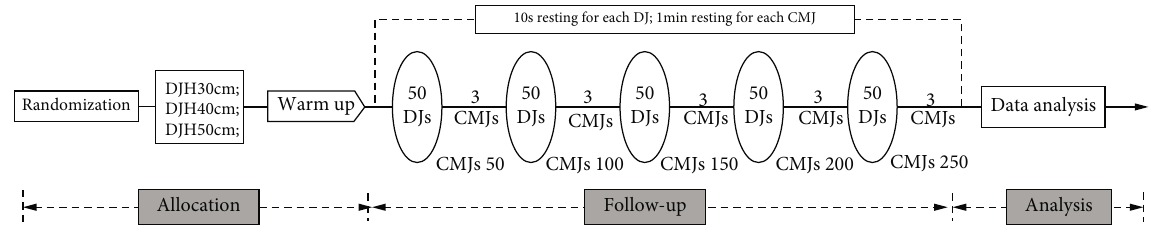
Figure 1: Schematic diagram of experiment. DJ: drop jump; CMJ: countermovement jump; DJH30: drop jump from 30 cm drop heights; DJH40: drop jump from 40cm drop heights; DJH50: drop jump from 50cm drop